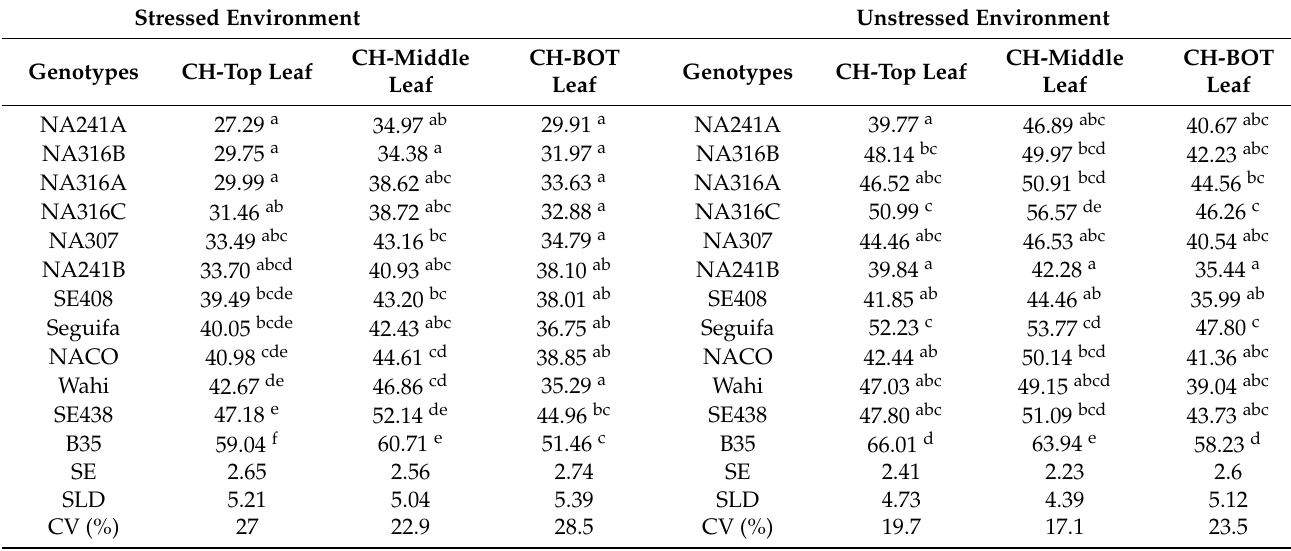
Table 4. Mean values of chlorophyll content for the top, middle and bottom leaves on sorghum genotypes in stressed and unstressed